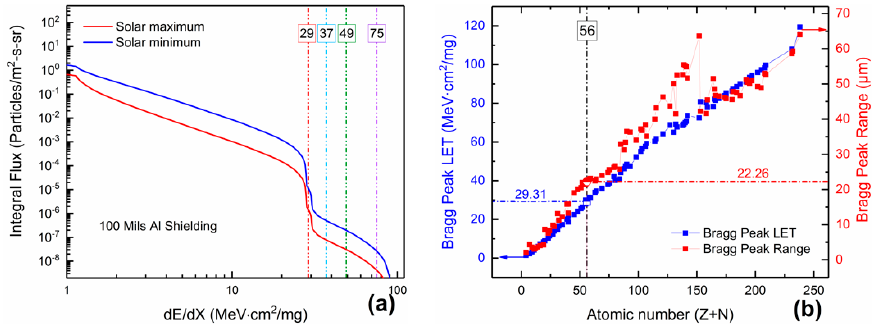
Figure 7. ( a ) The integral LET spectra of GEO Orbit for the solar maximum and the solar minimum conditions after 100 mils aluminum shielding. ( b ) The Bragg peak value of heavy ions (the left ordinate) and the corresponding range (the right ordinate) as a function of atomic number.